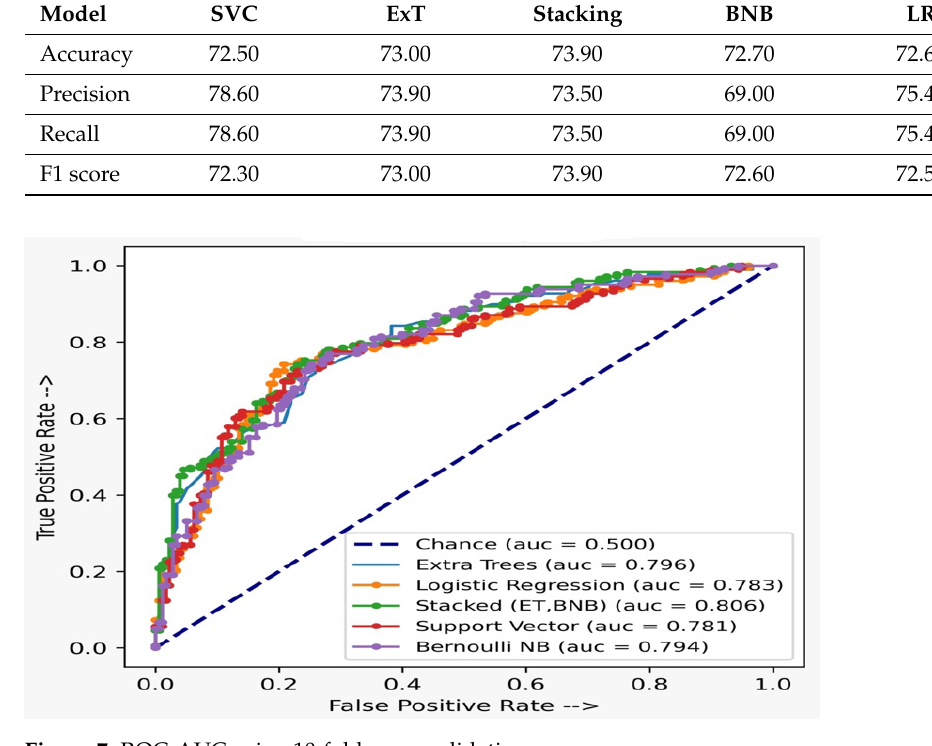
Figure 7. ROC-AUC using 10-fold